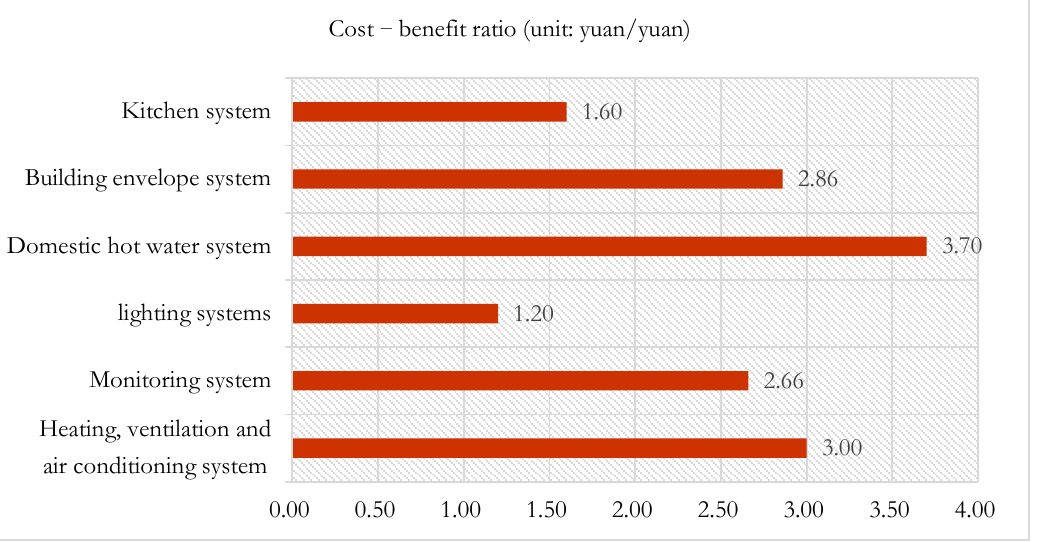
Figure 5. Cost – benefit ratio comparison of six energy-saving technologies used in the retrofit pro- ject.